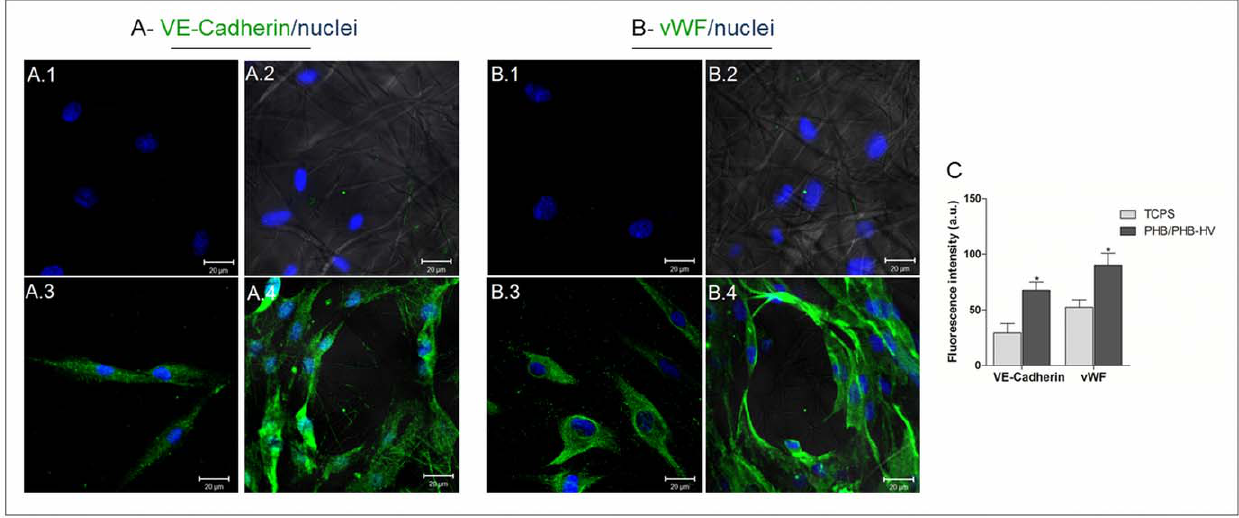
Figure 5. Protein expression of hASCs during endothelial differentiation. Confocal images of the expression of the VE-Cadherin (A) and the vWF factor (B) after 21 days. A.1 and B.1 - hASCs cultured with the basal medium on the TCPS coverslips, A.2 and B.2 - hASCs cultured with the endothelial differentiation medium on the TCPS coverslips, A.3 and B.3 - hASCs cultured with the basal medium on the electrospun PHB/PHB-HV fiber mesh, A.4 and B.4 - hASCs cultured with the endothelial differentiation medium on the electrospun PHB/PHB-HV fiber mesh. Scale bar 20 m m. The images, A.2, A.4, B.2 and B.4 represent the overlay of bright-field and confocal images for visualization of the fiber mesh. (C) Fluorescence intensity of the expression of VE-Cadherin and the vWF factor in cells differentiated on TCPS coverslip and electrospun PHB/PHB-HV fiber mesh. The results are expressed as the means 6 SD, (*) significant difference for p , 0,05. (a.u): arbitrary units.